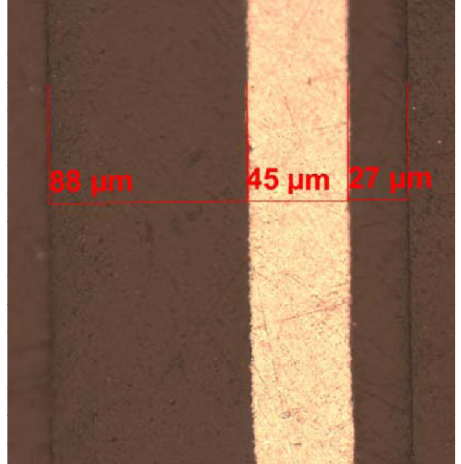
Figure 1. Microscope picture from a cross-section of the laminate material in a pouch cell: 88 μ m PP, 45 μ m aluminium foil and 27 μ m